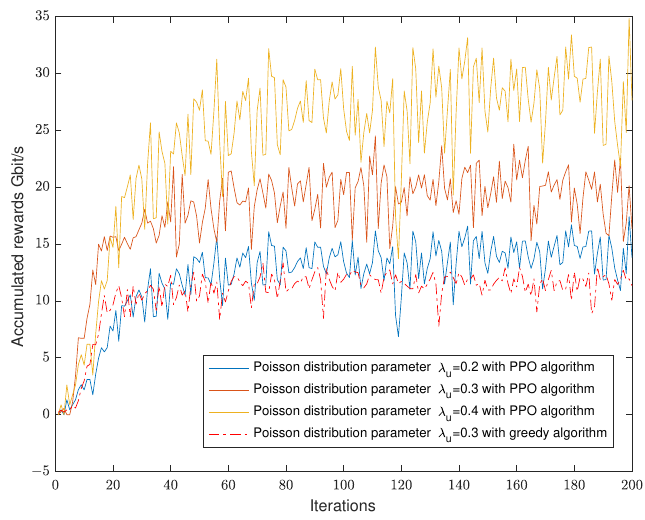
Figure 5. Number of iterations of the